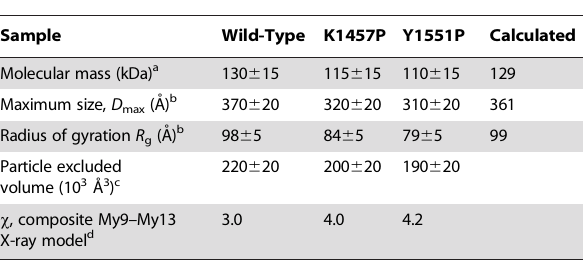
Table 2. To analyze flexibility, we generated 500 models deviating from the crystal structure within root mean square deviation up to